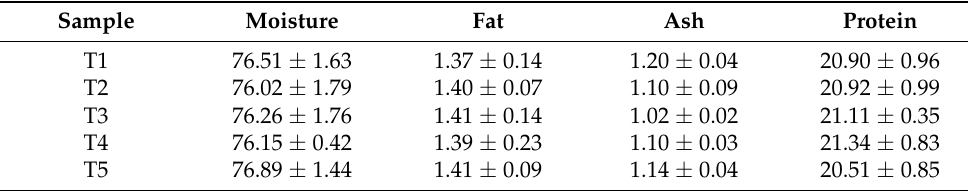
Table 2. Chemical composition (%) of chicken meat coated with chitosan containing AFEOs during storage at 4 ◦ C.